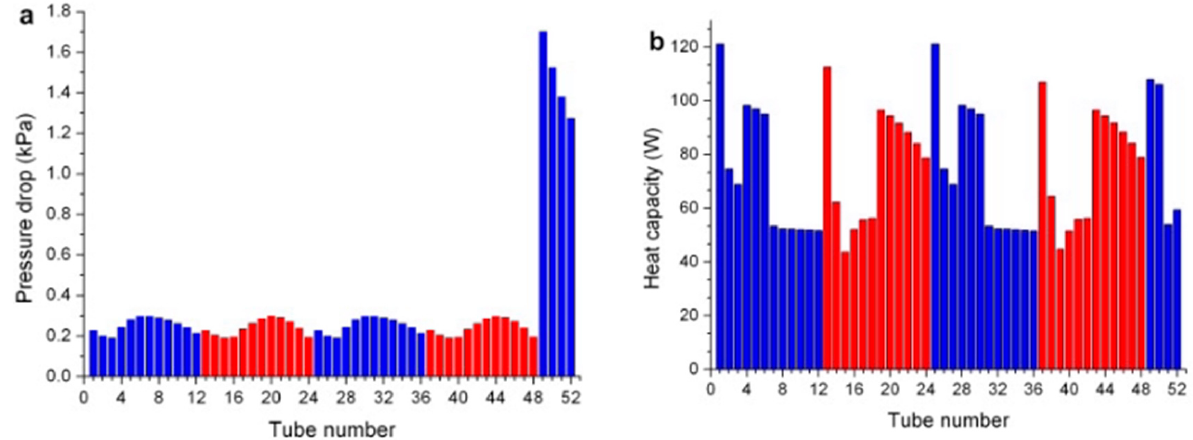
Figure 21. Results for the simulated condenser in terms of pressure drop ( a ) and heat capacity ( b ) [94].